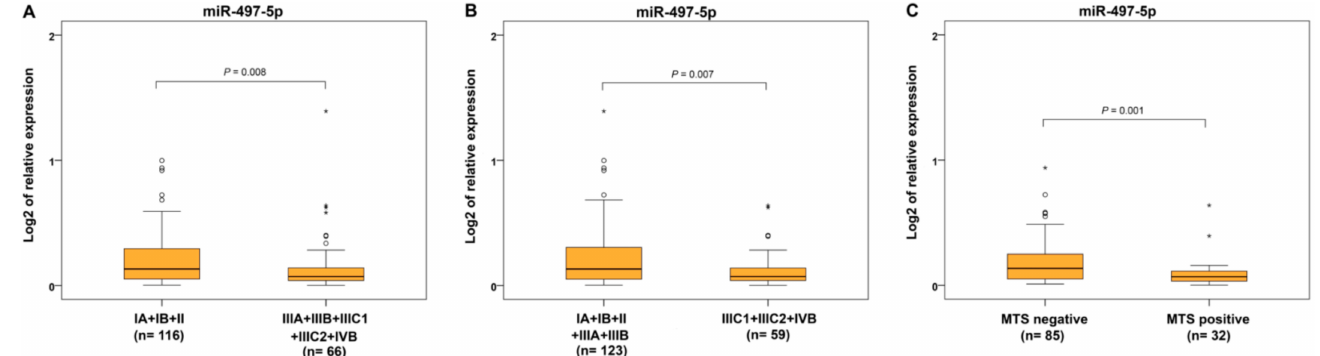
Figure 4. Relative expression of miR-497-5p in different International Federation of Gynecology and Obstetrics (FIGO) stages and metastasizing and non-metastasizing endometrial carcinomas. Differential expression between grouped FIGO categories: carcinomas in uterus (IA, IB, and II) and with local or regional involvement with lymph node and distant metas- tases (IIIA, IIIB, IIIC1, IIIC2, and IVB) ( A ), carcinomas in uterus or locally invading without metastases (IA+IB+II+IIIA+IIIB) and those including lymph node and distant metastases (IIIC1+IIIC2+IVB) ( B ), patients without and with distant metastases (MTS-negative and MTS-positive) ( C ). The lengths of the boxes show the interquartile range (IQR), which represents values between the 75th and 25th percentiles. ( of the box). (*) represents values greater than three IQRs. The horizontal line depicted median. Statistical significance is regarded as p <